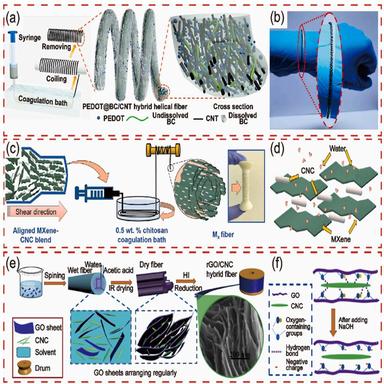
(a) Preparation process and structure of self-stretchable PEDOT@BC/CNT hybrid helical fiber. (b) Assembled supercapacitors are mounted on body parts for use. (c) schematic illustration of the fiber spinning process depicting the sheet alignment in LC MXene–CNC under spinning induced shear forces. (d) Schematic of the proposed CNC-induced bridging and alignment mechanism in MXene sheets resulting in liquid crystal behavior. (e) Schematic illustration for the fabrication of RGO/ CNC hybrid fiber. (f) Diagram